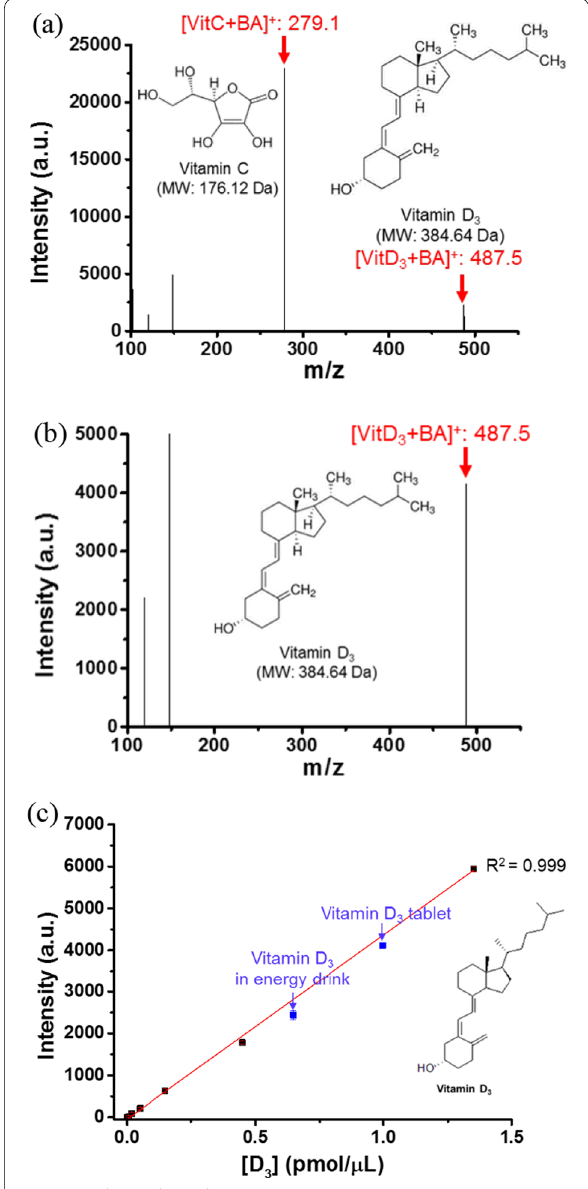
trometry based on a parylene matrix chip with good linearity ( r 2 0.994) and low LOD (0.0056 pmol/ =